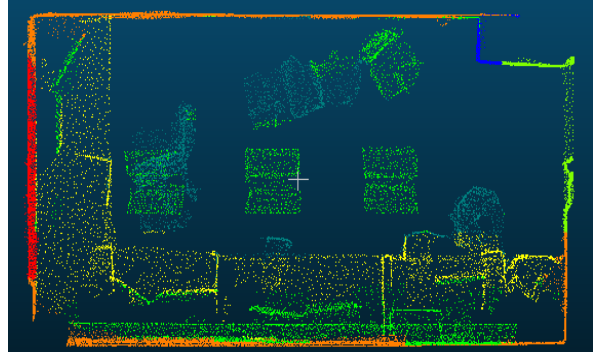
Fig. 4 Classification result of experimental